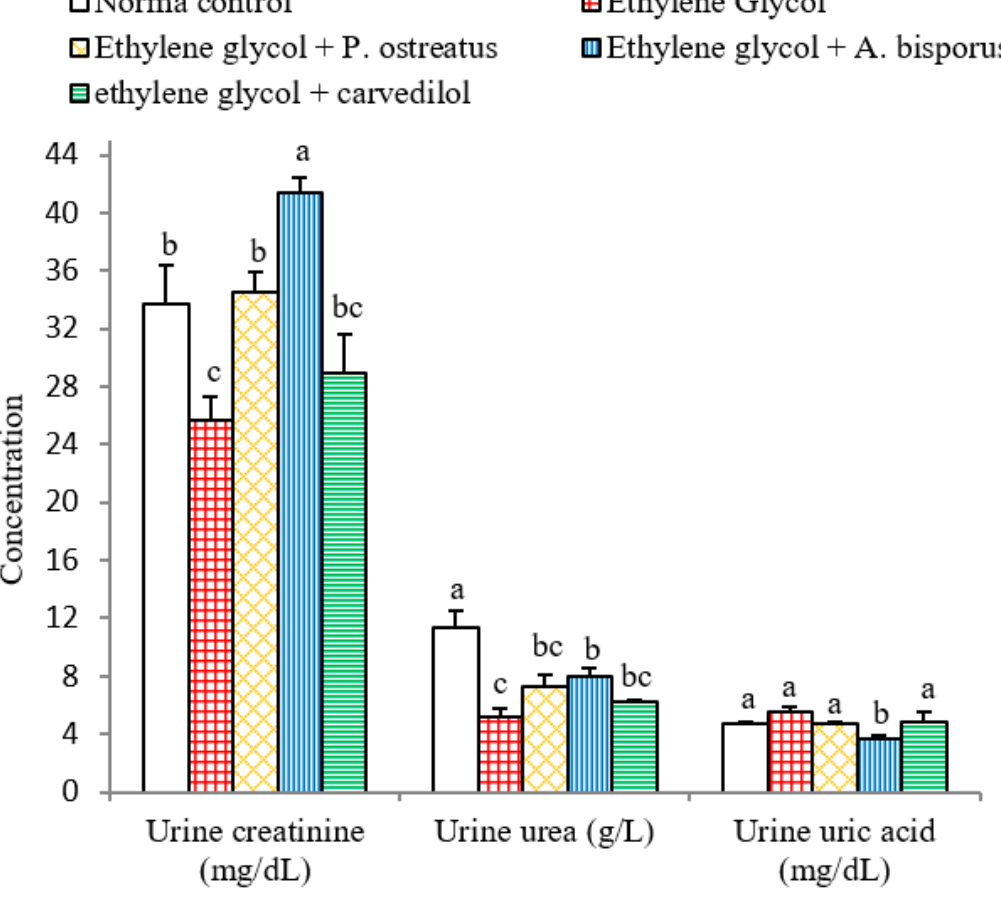
Figure 6. E ff ect of P. ostreatus and A. bisporus aqueous extracts and carvedilol on di ff erent urine Figure 6. Effect of P. ostreatus and A. bisporus aqueous extracts and carvedilol on different urine parameters related to renal e ffi ciency of ethylene glycol-administered rats. For each parameter, means parameters related to renal efficiency of ethylene glycol-administered rats. For each parameter, means which share the same letter(s) are not significantly di ff which share the same letter(s) are not significantly different.